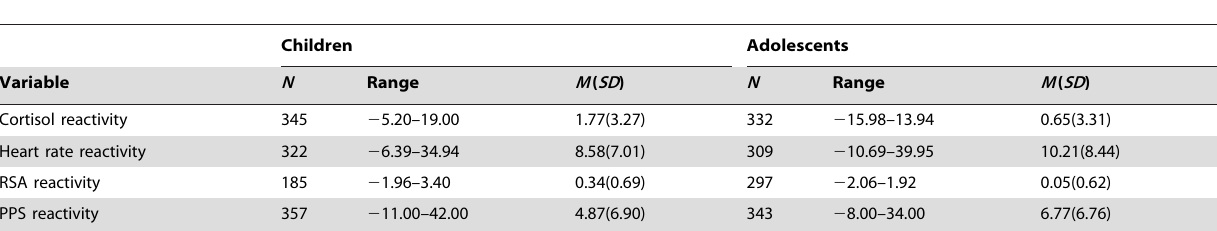
Table 2. Descriptives of stress reactivity